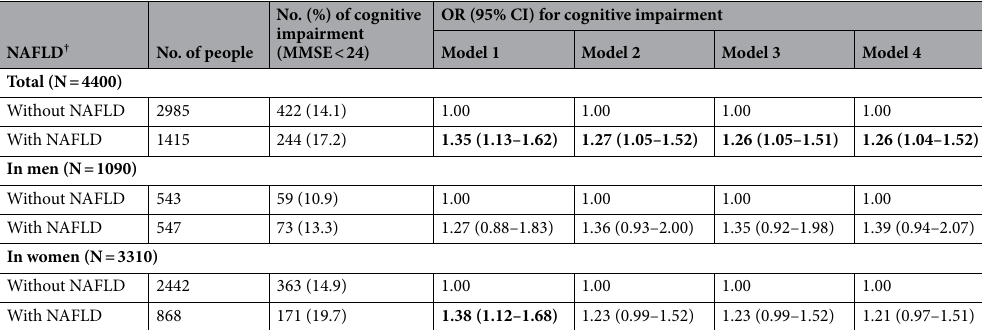
(Table 2). For the stratification by sex, the association between NAFLD and cognitive impairment was slightly larger in males (OR = 1.39; 95% CI = 0.94–2.07) than in females (OR = 1.21; 95% CI = 0.98–1.51). With stepwise additions of covariates, the ORs for cognitive impairment were altered after adjusting education level, household income, and marital status (OR = 1.35; 95% CI = 1.13–1.62 in model 1 vs. OR = 1.27; 95% CI = 1.05–1.52 in model 2), and this pattern was replicated in sub-groups by sex. The positive association between NAFLD and cognitive impairment was also maintained in the sensitivity analyses, which tested the association between NAFLD and the continuous MMSE score (Supplementary Table 2), the association between the continuous FLI value and cognitive impairment (Supplementary Table 3), and the association between the continuous values of FLI and the MMSE score (Supplementary Table 4). In the stratified analyses with inflammatory status, the association between NAFLD and cognitive impairment was significant in participants with a high inflammatory status (high WBC: OR = 1.70; 95% CI = 1.20–2.41, high hsCRP: OR = 1.54; 95% CI = 1.10–2.15), but not in those with a low inflammatory status (low WBC: OR = 1.09; 95% CI = 0.86–1.37, low hsCRP: OR = 1.25; 95% CI = 0.98–1.59) (Fig. 1). The interaction on the association of the WBC strata was statistically significant in women (high WBC: OR = 1.81; 95% CI = 1.19–2.74 vs. low WBC: OR = 1.02; 95% CI = 0.78–1.33, interaction-p = 0.05), but almost absent in men (high WBC: OR = 1.38, 95% CI = 0.73–2.67 vs. low WBC: OR = 1.42, 95% CI = 0.85–2.37, interaction-p = 0.97). The associations in high hsCRP strata were seemed to be stronger than in low hsCRP strata in both men (high hsCRP: OR = 1.74; 95% CI = 0.89–3.51 vs. low hsCRP: OR = 1.23; 95% CI = 0.75–2.02, interaction-p = 0.70) and women (high hsCRP: OR = 1.47; 95% CI = 0.99–2.17 vs. low hsCRP: OR = 1.26; 95% CI = 0.95–1.66, interaction-p = 0.90), but there were no statistical effect modifications.